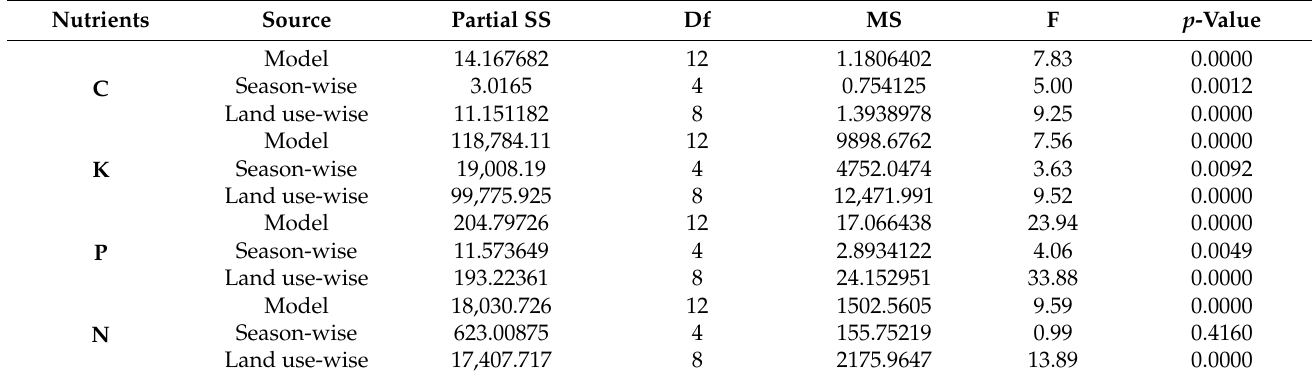
Table 5. The two-way ANOVA result of soil nutrients (C, K, P, and